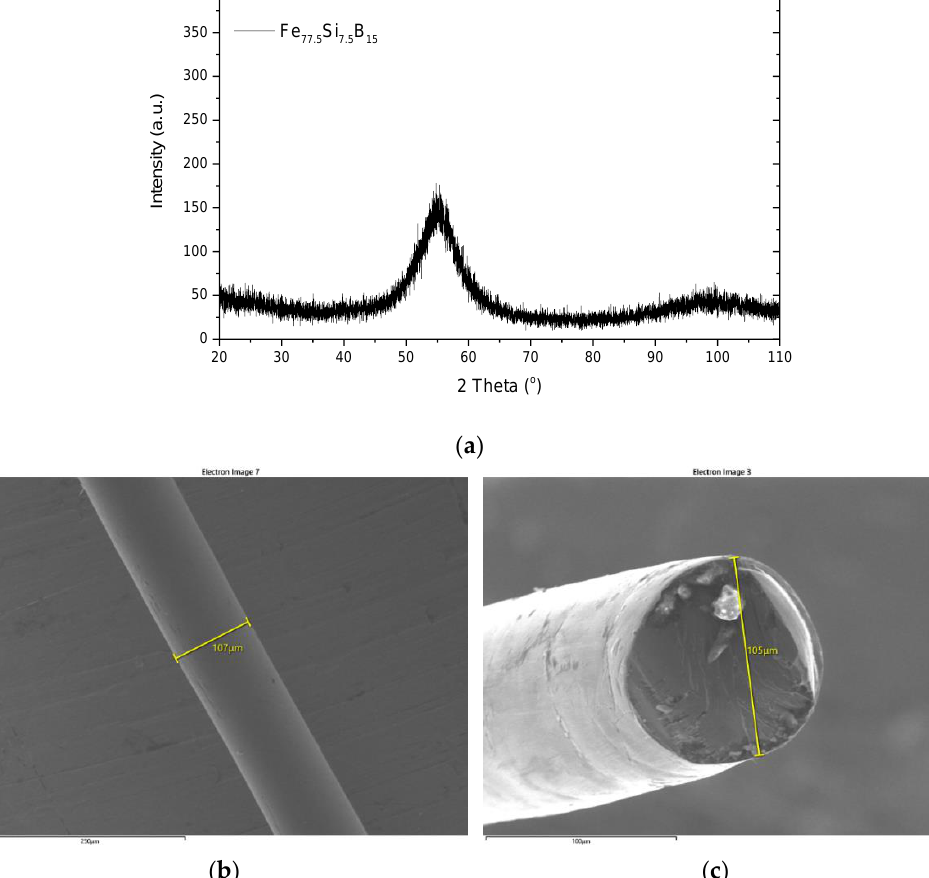
Figure 1. XRD pattern of the Fe 77.5 Si 7.5 B 15 at.% fibres ( a ), SEM images of the surface ( b ) and cross- section ( c ) of the fibres used in this study.